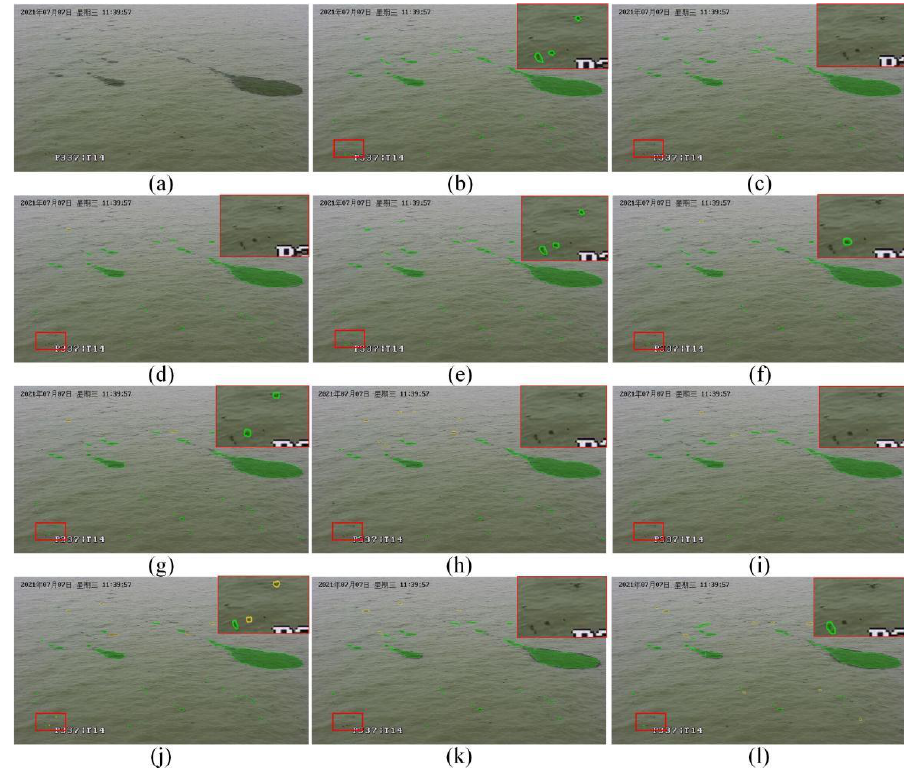
Figure 14. The visual comparison of results of different models in scene 1.